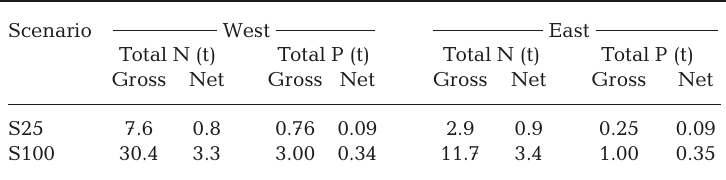
Table 4. Difference in gross and net transports of total N and total P from the offshore fish farms to the western and eastern coastal water areas relative to